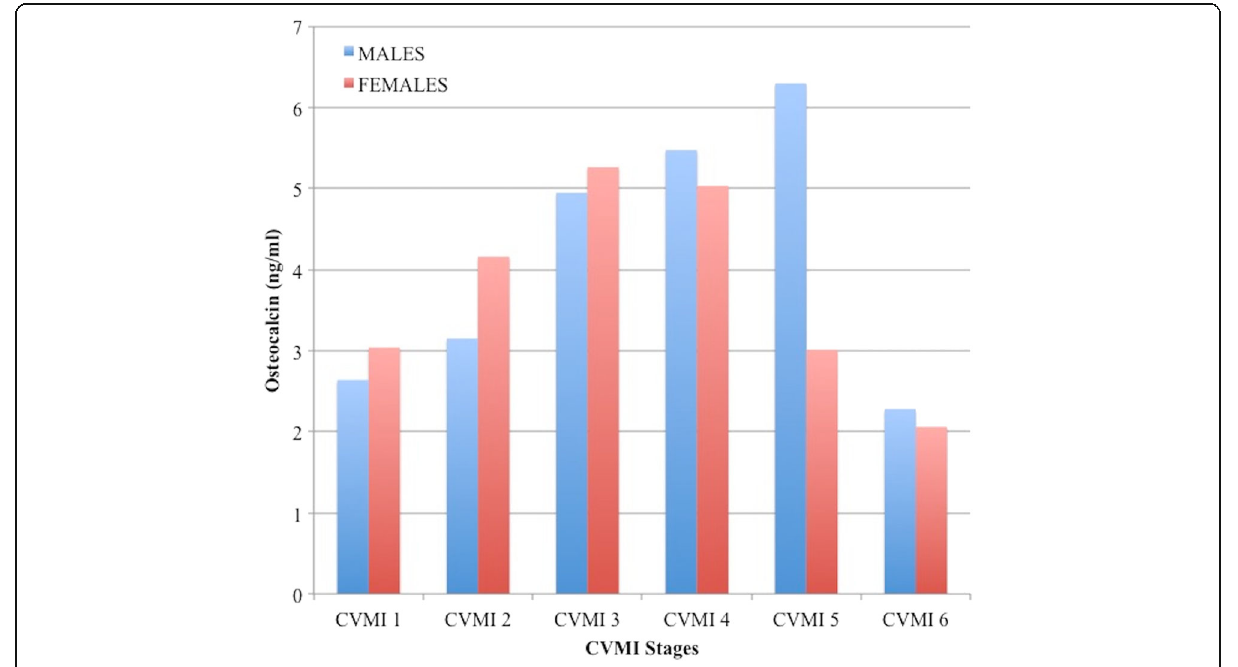
Fig. 2 The distribution and comparison of mean serum osteocalcin levels in males and females in the six CVMI